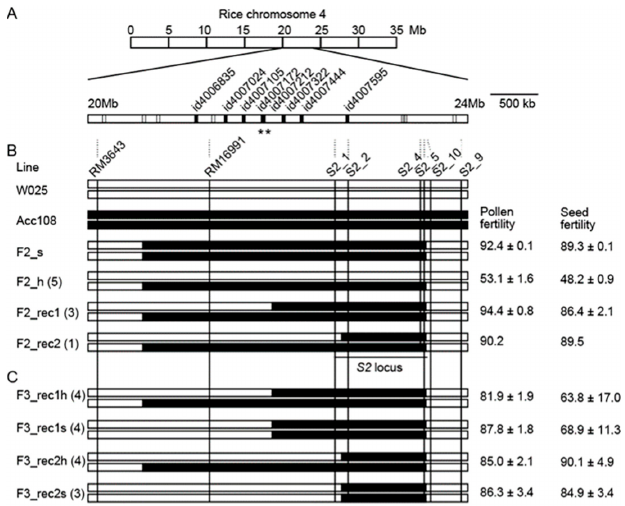
Figure 2. Genetic mapping of the S 2 locus. ( A ) Chromosome-wide and region-specific views showing location of polymorphic markers. Eight polymorphic markers were found between 20Mb and 24Mb region on chromosome 4. Black and white boxes in the region-specific view indicate the position of polymorphic and non-polymorphic markers, respectively. Positions of two closely linked SNP markers (id4007172 and id4007212) were also shown by asterisk. ( B ) Graphical genotypes of W025, Acc108 and F 2 plants derived from the cross between W025 and W025S2s. White and black bars indicate chromosomes derived from O. glaberrima and O. sativa , respectively. Pollen and seed fertility of F 2 plants divided into four genotypes (W025S2s homozygotes, heterozygotes, and recombinant class 1 and 2) are shown on the right side of graphical genotypes. Number of plants in each genotype was shown in parenthesis. ( C ) Graphical genotypes of F 3 plants obtained by self-pollination of two F 2 genotypes (recombinant class 1 and 2)). F 3 plants were classified by genotype of the marker RM16991. From the recombinant class 1, four and four F 3 plants showing heterozygous and homozygous for the O. glaberrima type in the marker RM16991 were obtained. From the recombinant class 2, four and three F 3 plants showing heterozygous and homozygous for the O. glaberrima type in the marker RM16991 were obtained. The average pollen and seed fertilities with the standard error of each genotype class were